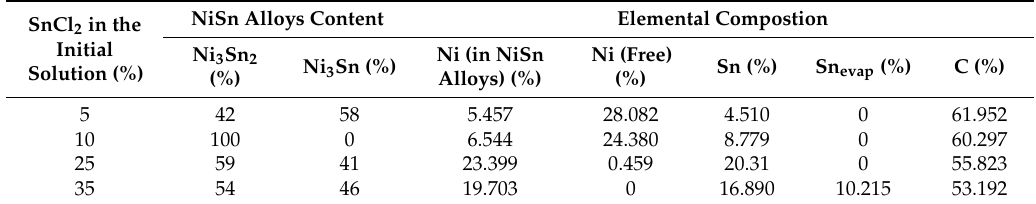
Table 1 . Composition of the produced nanofibers produced at 850 °C. Table 1. Composition of the produced nanofibers produced at 850 ◦ C.